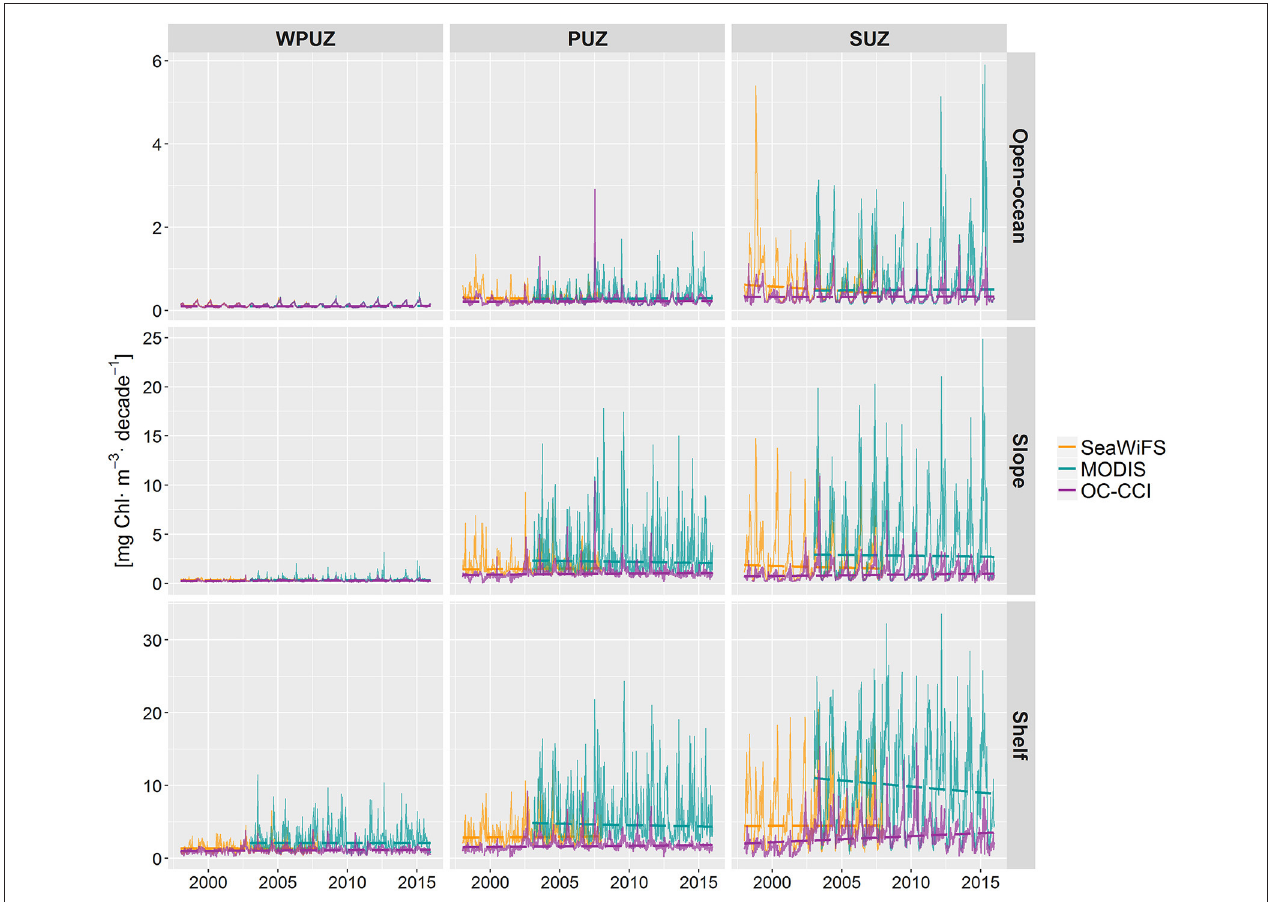
FIGURE 7 | Average Chl-a time-series (light, solid lines) and average trends (dark, dashed lines) for the 1998–2015 period for various datasets in each of the upwelling subregions, over the shelf (0–200m), continental slope (200–2,000m) and open-ocean region ( > 2,000m, as far as 28 ◦ W). Trend values and their significance is shown in Table 1